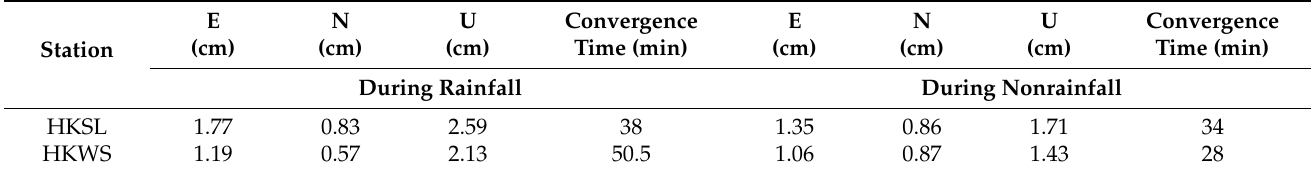
Table 4. Positioning error and convergence time of real-time multi-GNSS PPP.